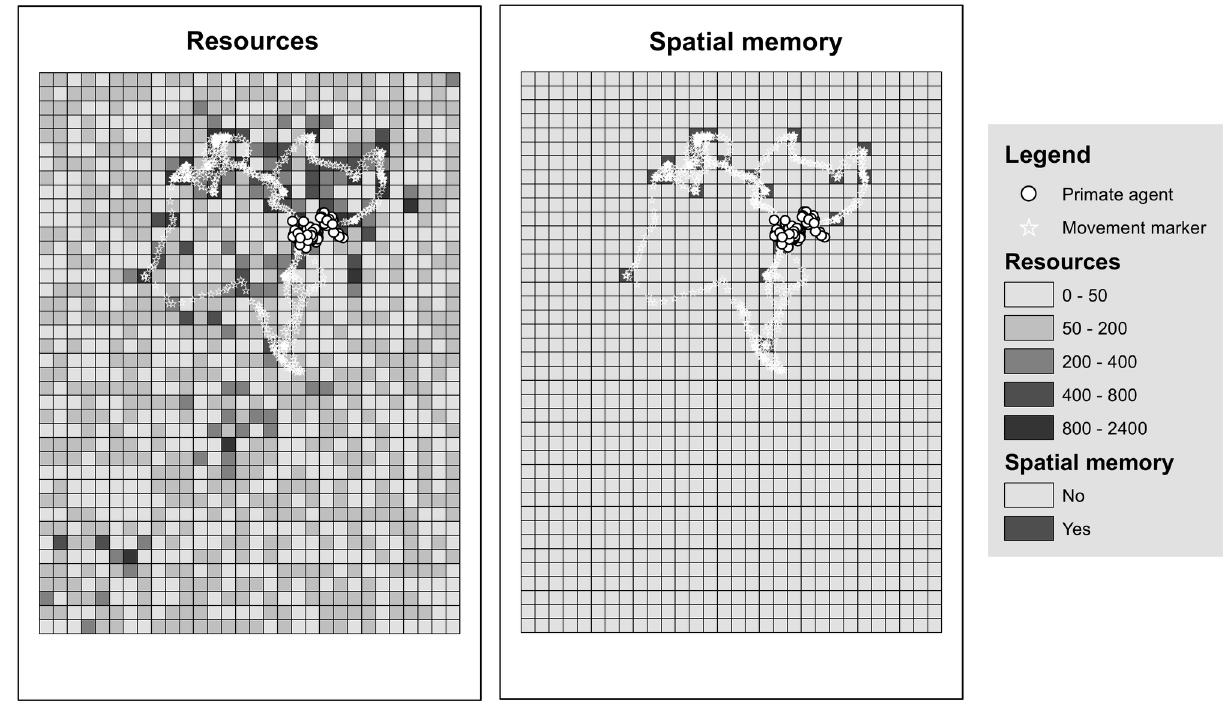
Figure 2. Simulation environment representing: primates (dots), recorded group position (stars), resource and memory landscapes